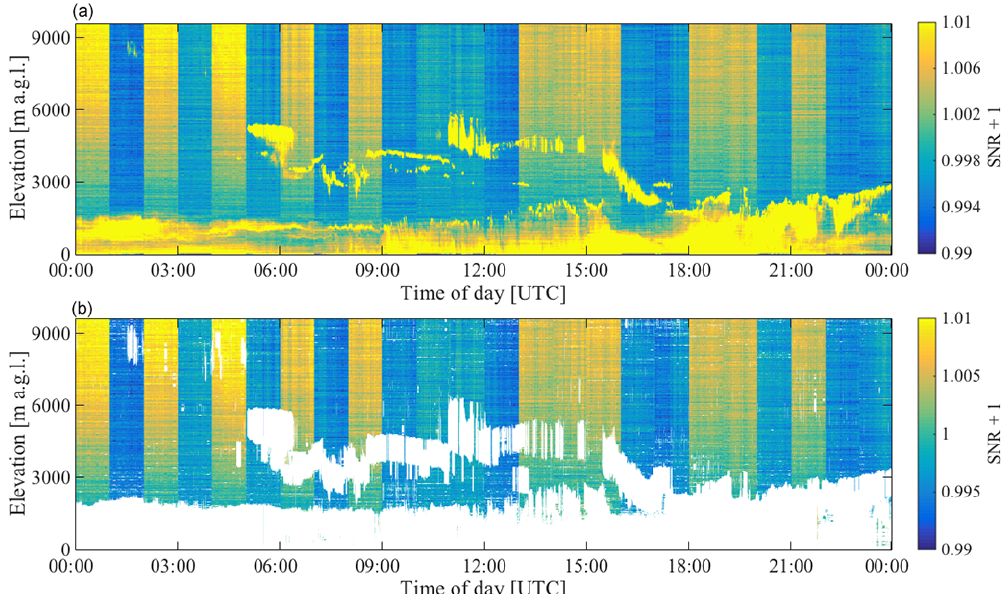
Figure 7. An example illustrating the performance of the cloud-aerosol masking scheme: (a) uncorrected SNR from a Halo Doppler lidar at Hyytiälä, Finland, on 21 May 2014, and (b) same data after cloud and aerosol have been identified and removed (masked regions in